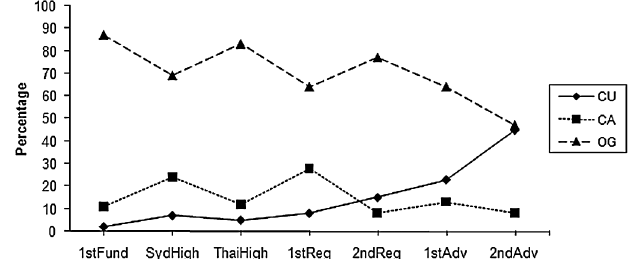
strings.FIG. 1. The percentages of students’ responses obtained using the categorizing and counting technique are plotted against previous engagement with physics learning (ranked as in Table II) for questions 2 and 3 on the speed of